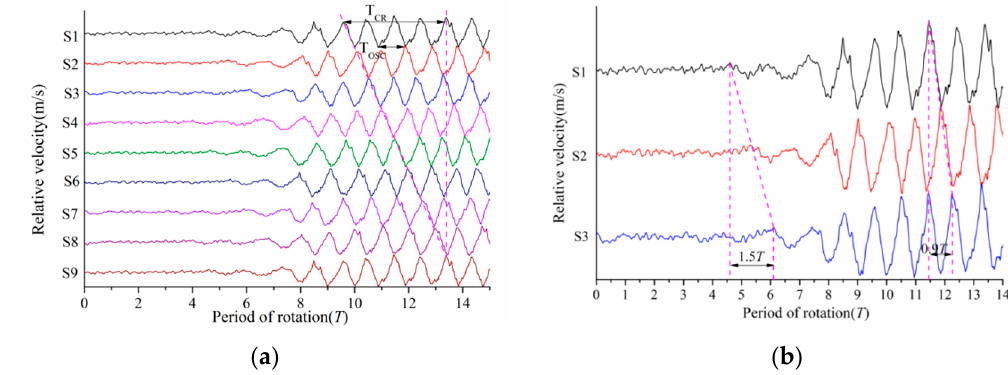
Figure 7. Relative velocity curve of the monitoring point when the flowrate is 1.1 kg/s: ( a ) the curve of relative velocity at 8 points; ( b ) the curve of relative velocity at 3 adjacent points.